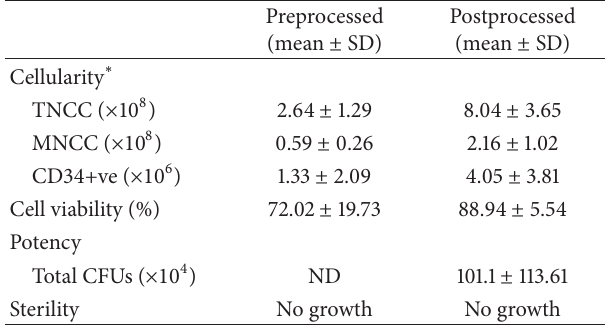
Table 2: Cell product